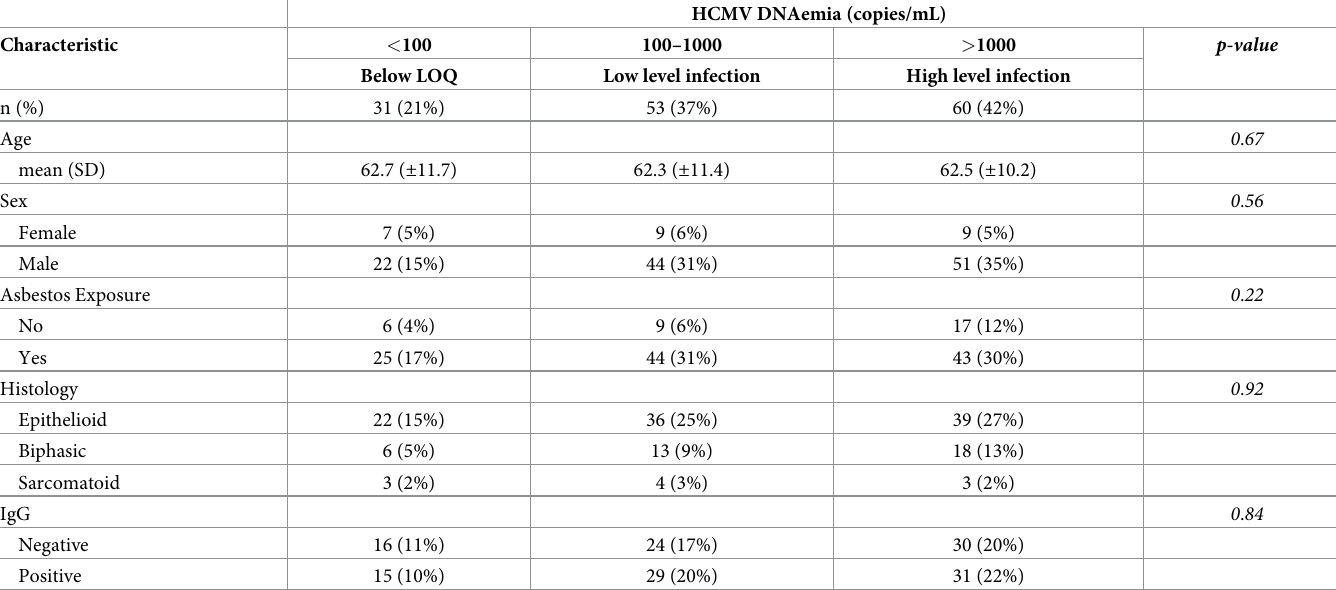
Table 1. Clinical characteristics of MPM patients (n =